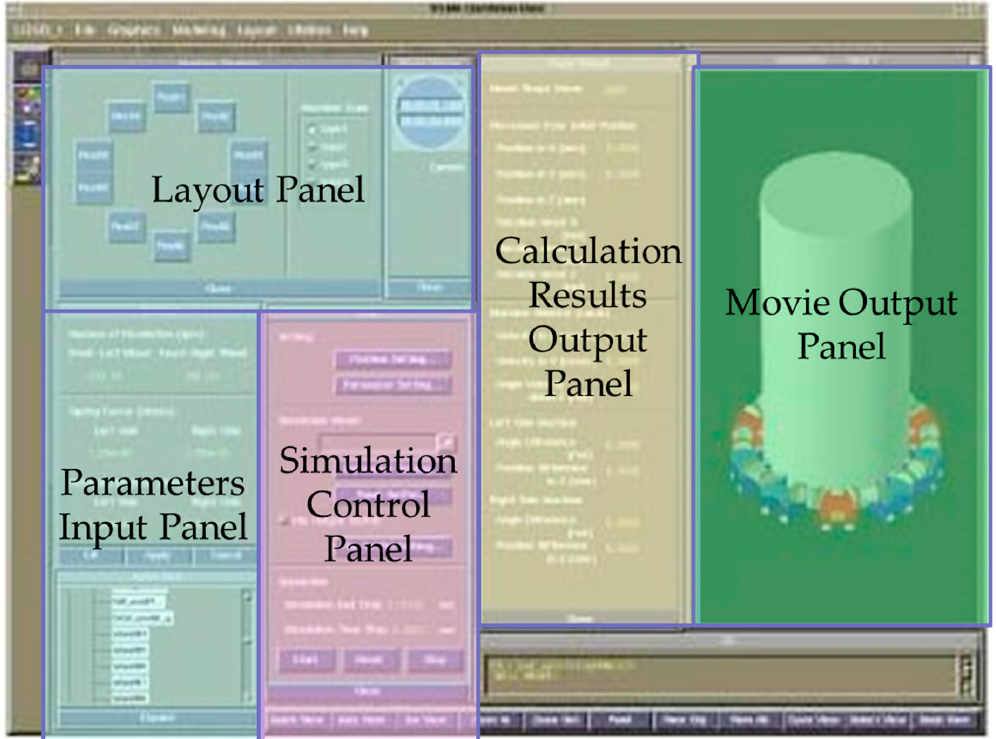
Figure 3. Input / output panel of the vertical climbing simulator for multiple connected microrobots. The left and upper left areas show panels for the input of parameters and layout around a small cylinder. The center left area shows the simulation control panel. The center right area shows the calculation results output panel. The right area shows the movie output panel.